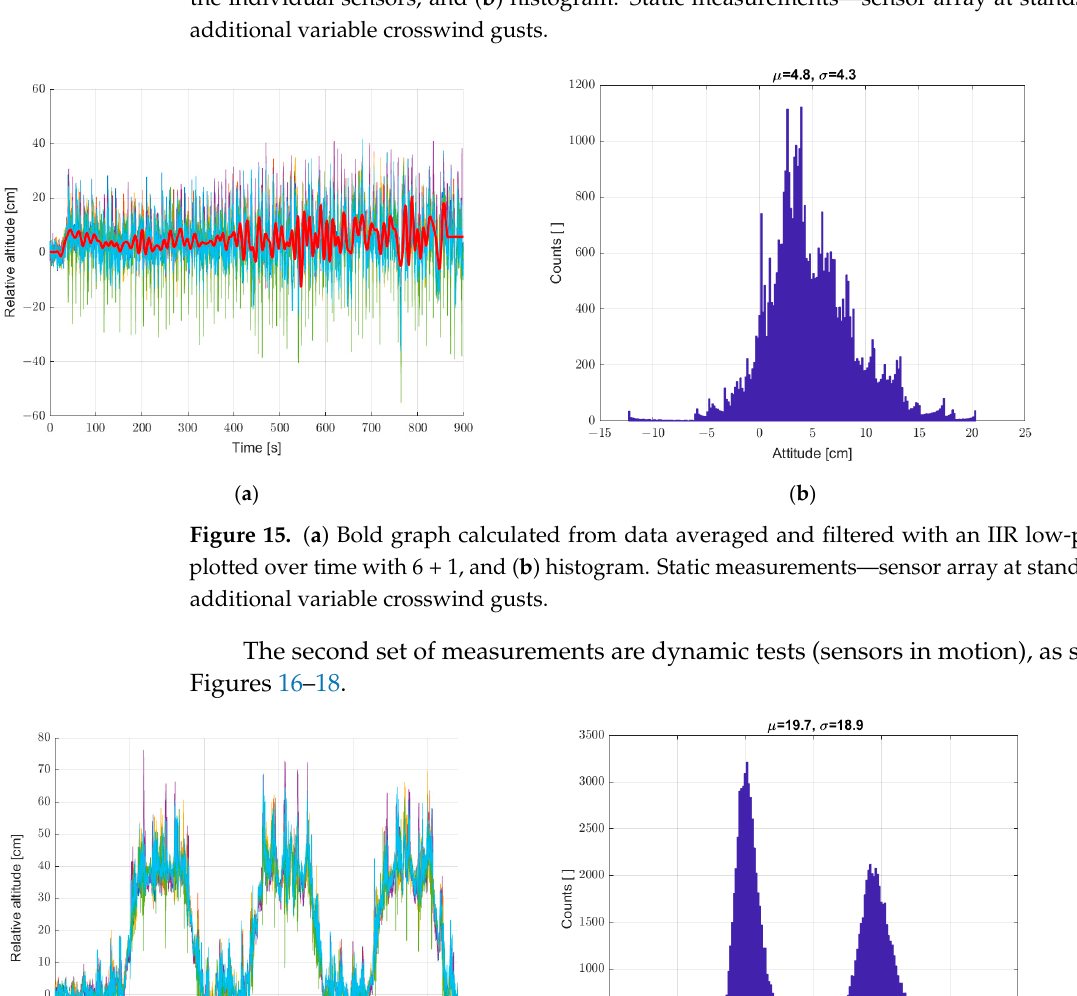
( b ) Figure 17. ( a ) Graph over time from 6 + 1 sensors, bold graph calculated from the average of indi- vidual sensors, and ( b ) histogram. Dynamic measurements—sensor array in motion, with addi- tional variable crosswind gusts.